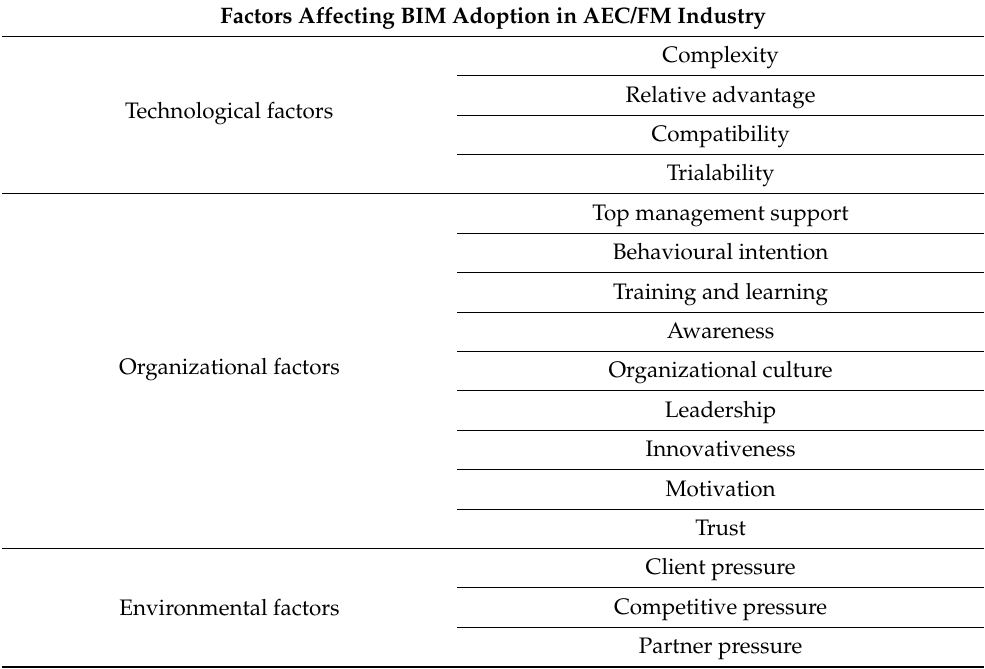
Table 1. Factors affecting BIM adoption in the AEC/FM industry, adapted from ref.